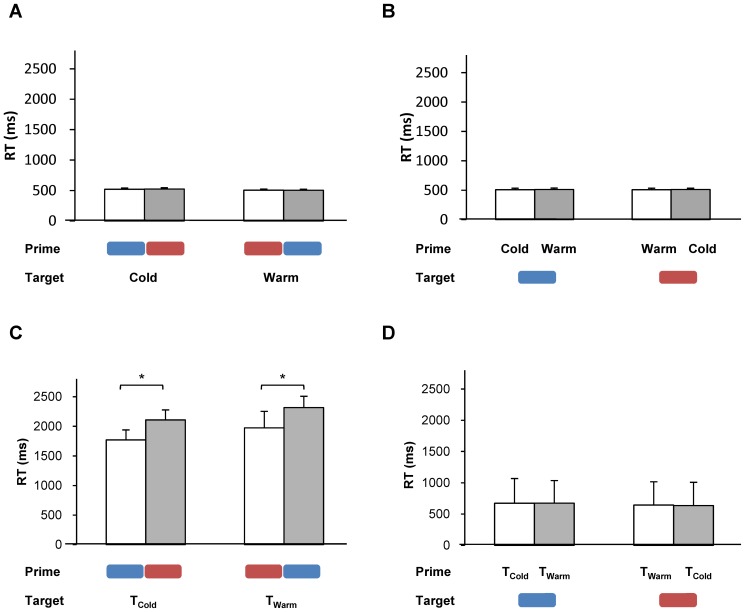
Results of the priming task.RTs for participants discriminating (A) thermal words and (B) colour stimuli in Experiment 2A, and (C) physical temperature and (D) colour stimuli in Experiment 2B. Congruent and incongruent combinations are shown in white and gray, respectively. Error bars denote the standard errors of the means. * indicate statistical significance of p<.05 (paired one-tailed t test: A one-tailed test is justified in this case given our prediction that the congruent combinations would give rise to shorter RTs than the incongruent combinations).